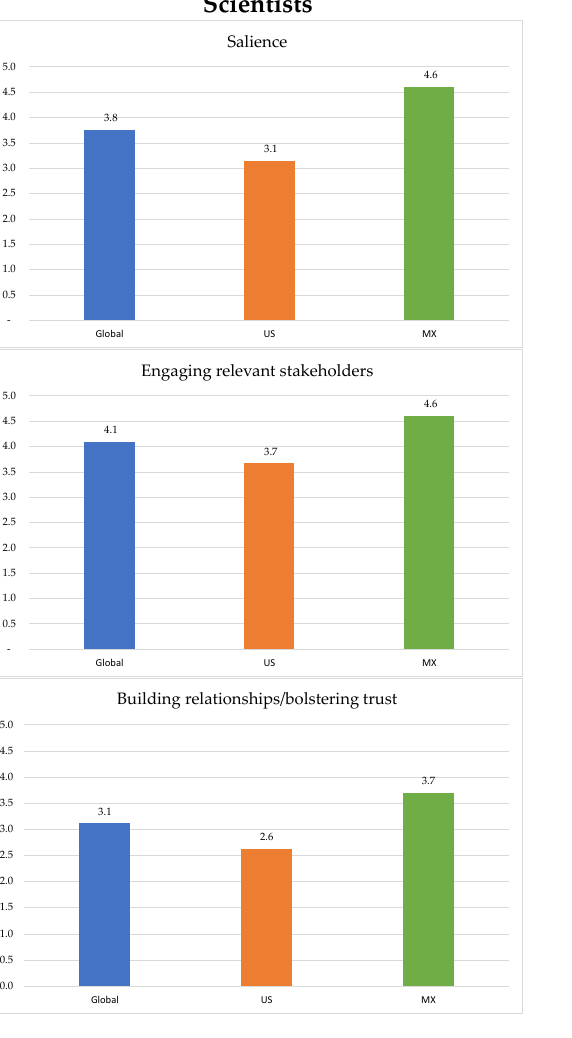
Figure 4. Summary of interview scores. Table 1. Science production and relevant attributes of science outputs in the TAAP.